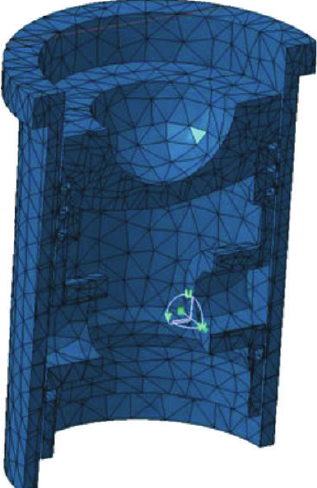
Figure 5: Meshed piston cylinder model.